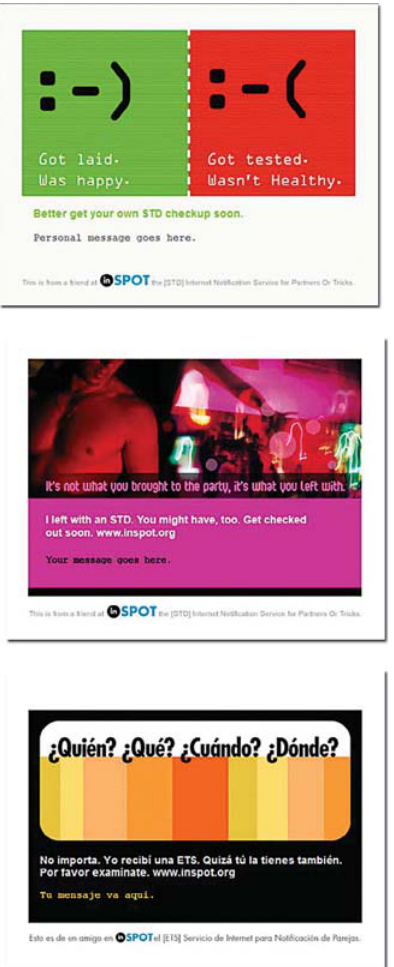
Figure 1. Examples of